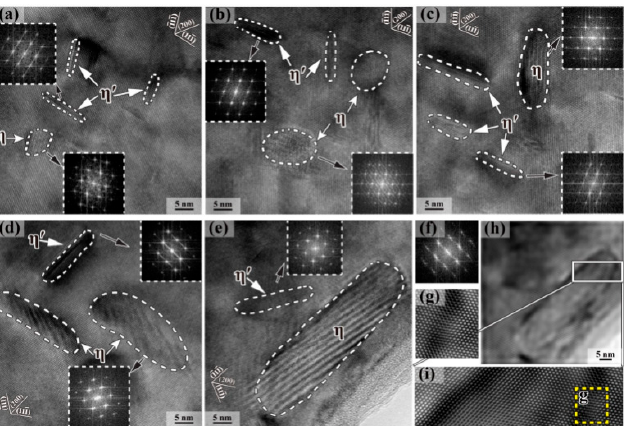
Figure 9. HRTEM images of the precipitates viewed along <110> Al orientation in 7085 alloy after various heat treatments: ( a ) sample I (25 °C); ( b ) sample II (100 °C); ( c ) sample III (125 °C); ( d ) sample IV (150 °C); ( e ) sample V (175 °C); ( f ) corresponding FFT pattern of η phase in (e); ( g ) is from the yellow dashed frame in (i); ( h ) is the corresponding inverse FFT image of ( e ), and; ( i ) is from the white solid frame in (h). Adapted with permission from ref. [55]. 2021 Zang et